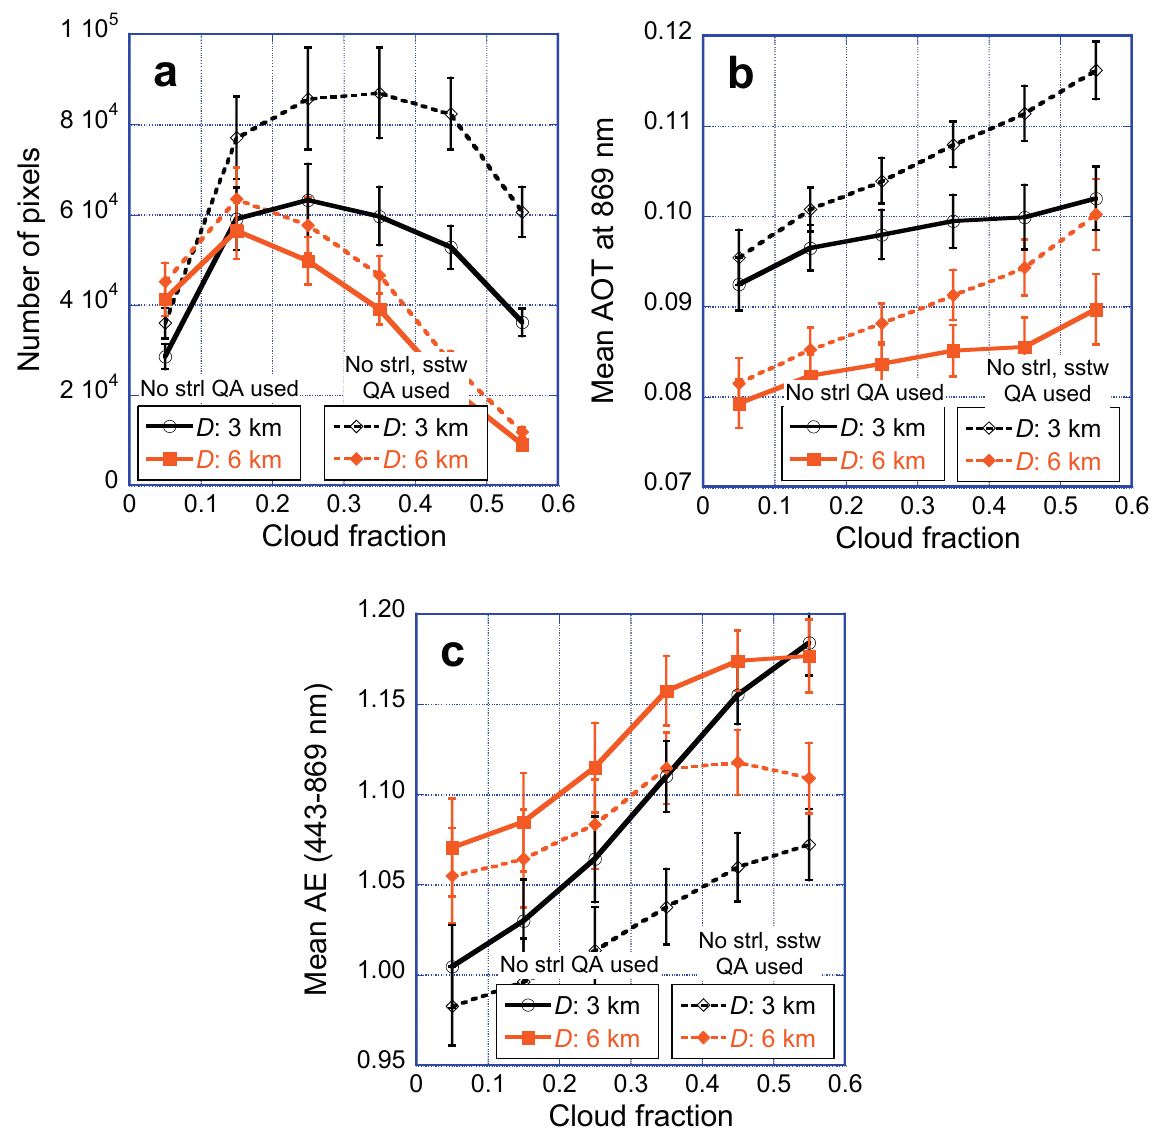
Figure 7. Same as Figure 4 (solid lines), but also showing the results (dashed lines) when the data selection ignores warnings by both the straylight and sstwarn QA flags. ( a ) Number of pixels; ( b ) Aerosol optical thickness; ( c ) Angstrom